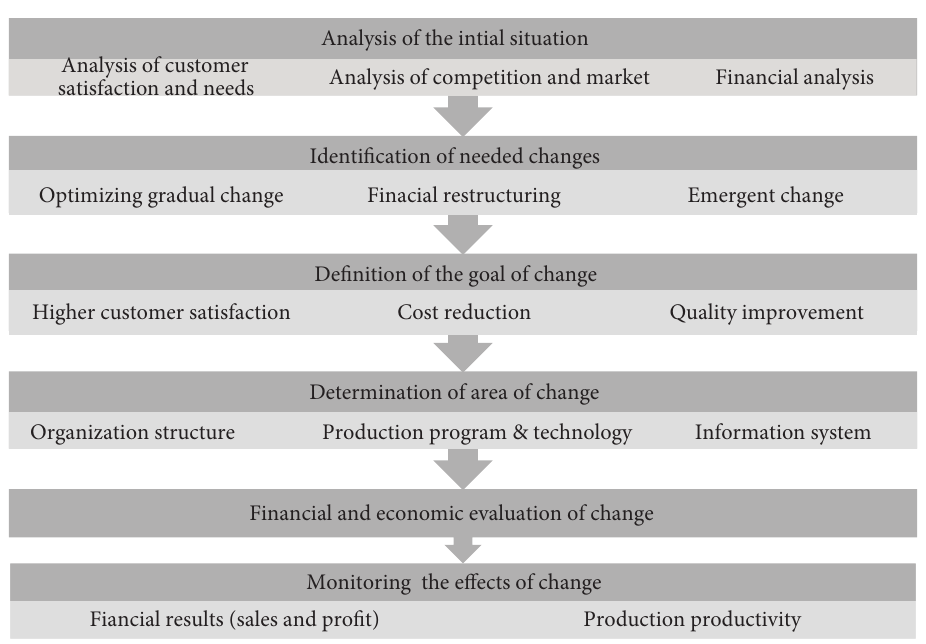
Figure 7. The process by implementing changes in Slovak companies (source: own processing) The process presented in Figure 7 includes all steps by managing changes used in sur- veyed enterprises and the most frequent analyses, type of change, goals defined for changes, areas of performed changes that were found out in the empirical research. It is the real situ- ation in Slovak enterprises in the field of change management. Some important parts for successful implementation of changes are missing in Slovak